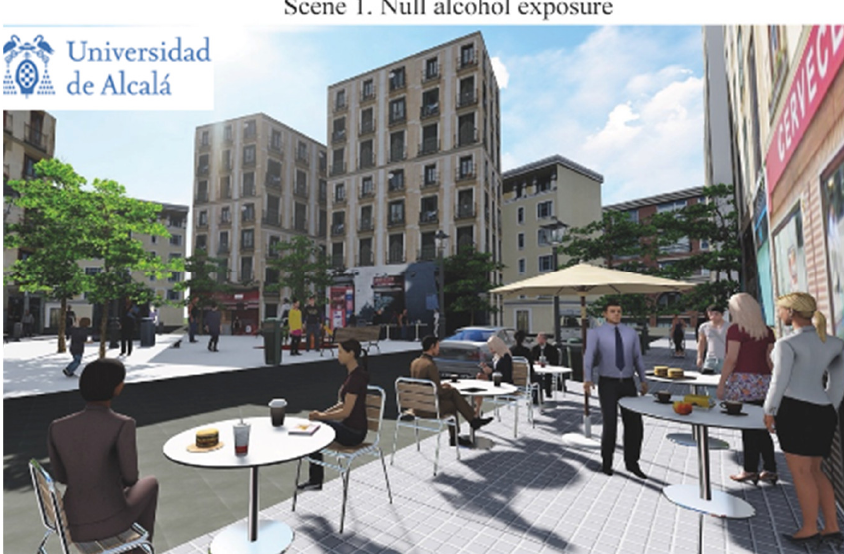
Figure 3. Null alcohol exposure scenario.